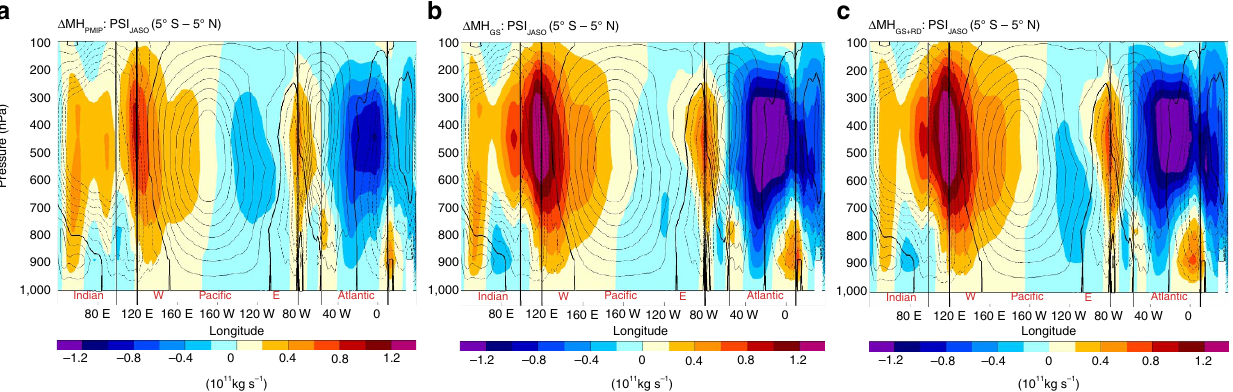
Figure 3 | Nin˜o 3.4 index composite and Bjerknes feedback for each experiment. ( a ) Nin˜o 3.4 index composite of the mean El Nin˜o development and decay in the preindustrial (PI), MH PMIP (only orbital changes), MH GS (orbital and vegetation changes) and MH GS þ RD (orbital, vegetation and dust changes). The shadings show the standard error of the mean. The statistical significance of the changes has been further tested through a bootstrap technique using an extended PI simulation—575 years (Supplementary Fig. 9); ( b ) Total Bjerknes positive feedback index (BPF) and each single component (Thermocline—TH, Upwelling—UP, and Zonal Advection—ZA feedback) for each experiment. The total BPFand the relative standard error of the mean are: 3.0 ± 0.2 yr (cid:2) 1 for the PI; 2.65 ± 0.09 yr (cid:2) 1 for the MH PMIP ; and 2.5 ± 0.2 yr (cid:2) 1 for both MH GS and MH GS þ RD experiments. The standard error of the mean has been calculated performing the BPF for sliding windows of 30 years and 10-year steps.